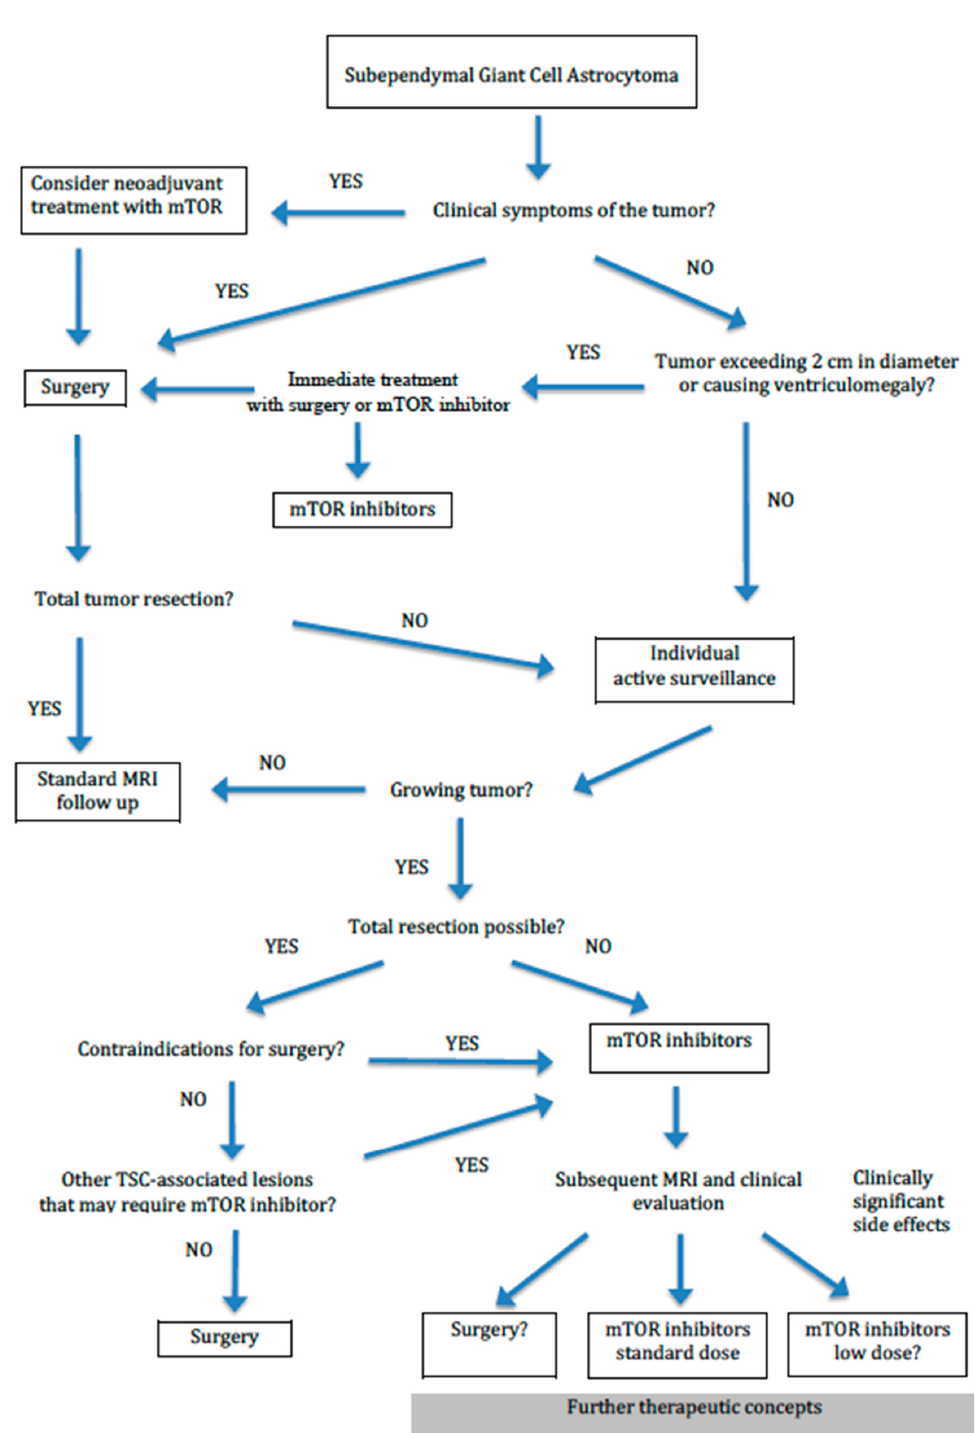
Figure 5. Algorithm of SEGA management (modified from Jozwiak et al. [7]).